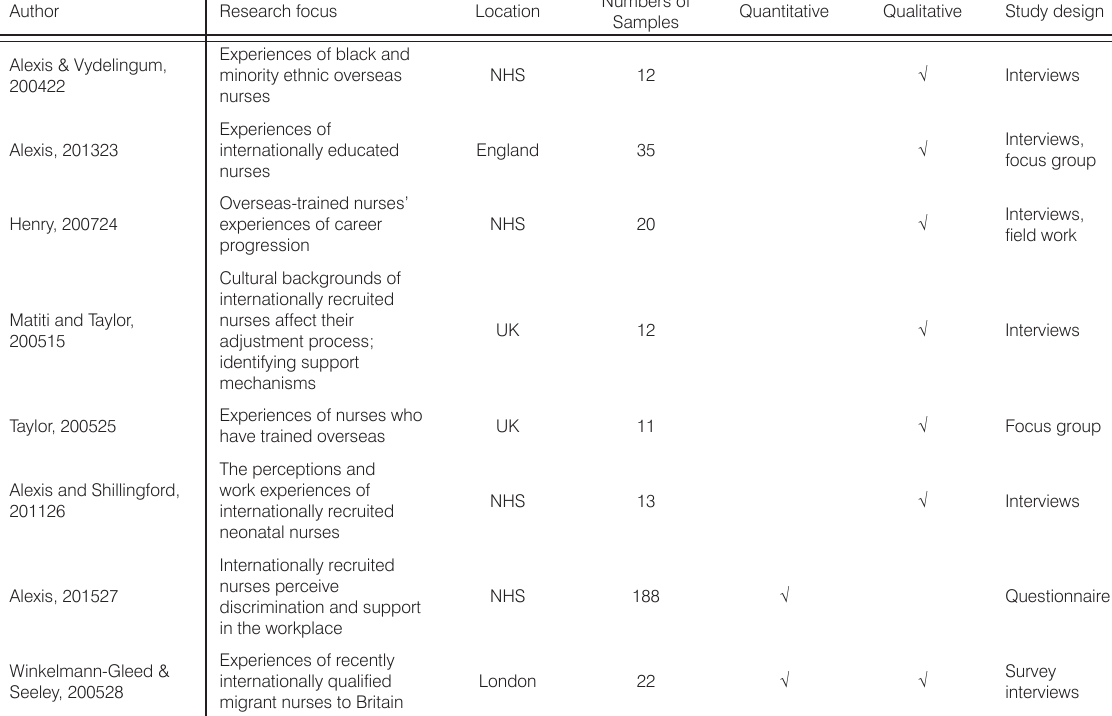
Table 2. Data extracted from the 8 selected